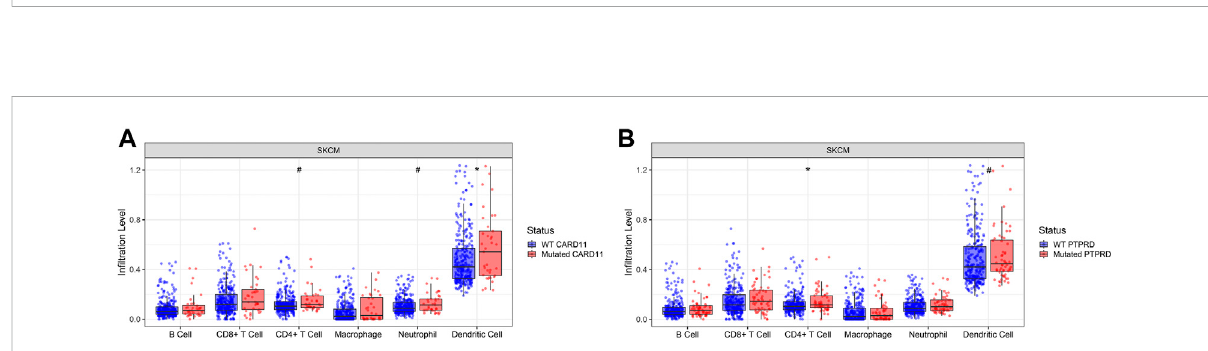
FIGURE 3 CARD11 and PTPRD genes were associated with higher tumor-in fi ltrated immune cell abundance in skin melanoma tumor samples from The Cancer Genome Atlas database. (A) . CARD11 gene mutational status was signi fi cantly associated with more dendric cells ( p < 0.05), and also associated with more CD4+ T cells and neutrophilic cells ( p < 0.1). (B) . PTPRD gene mutational status was signi fi cantly associated with more CD4+ T cells ( p < 0.05), and was also associated with more dendric cells ( p < 0.1). *: p ＜ 0.05, #: p < 0.1.